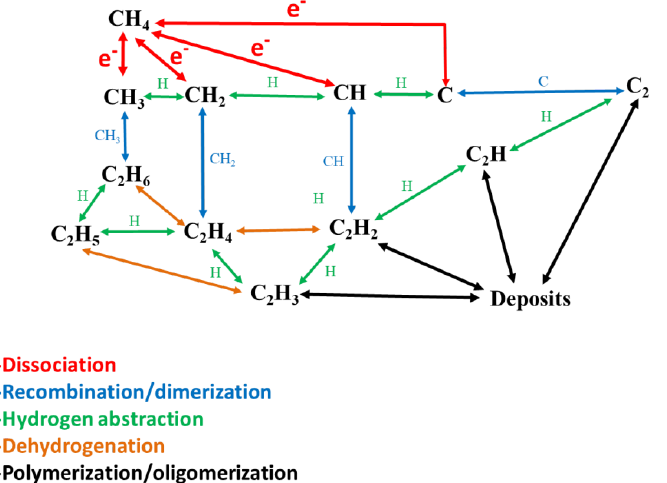
Figure 8. Proposed reaction pathways and radical reactions in coupling of methane to C 2. and deposits in 304 the DBD plasma reactor. 305